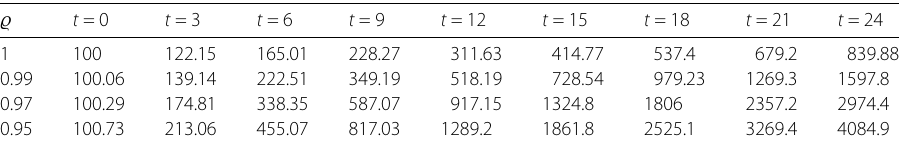
Table 2 Values of I ( t ) for four different orders of CF D (cid:2) (cid:2)